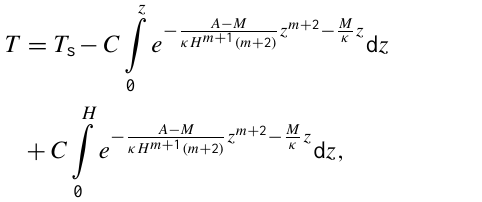
Fig. 1. Left: comparison of the EDC3 age scale (red) (Parrenin et al., 2007a) and the modeled age scale using the simple 1-D model with m = 0.5 (black), m = 0.3 (blue) and m = 0.7 (purple). Right: com- parison of the measured Dome C temperature profile (red) and the modeled temperature profile using the 1-D model for m = 0.5 with constant thermal conductivity K and heat capacity c at the bottom temperature T b = 270.4K (black), at the measured mean tempera- ture over the entire ice column T m = 240.9K (blue) and using tem- perature dependent K and c (green). Also shown are versions with constant K and c using the bottom temperature, but for m = 0.3 (blue) and m = 0.7 (purple), which are very similar to the one for m =